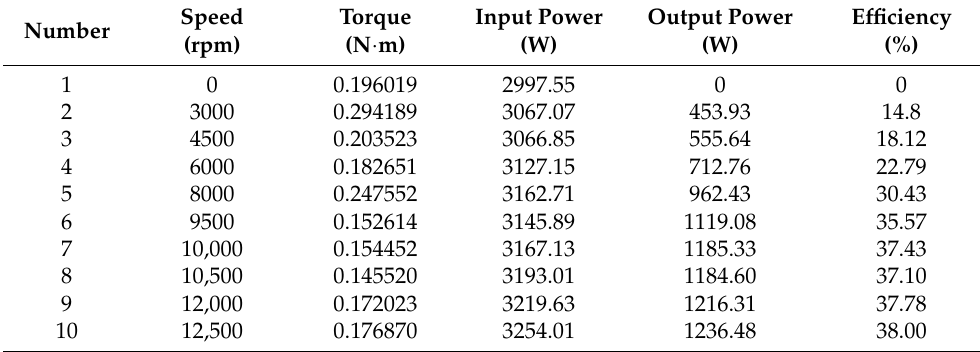
Table A1. Prototype Performance Test